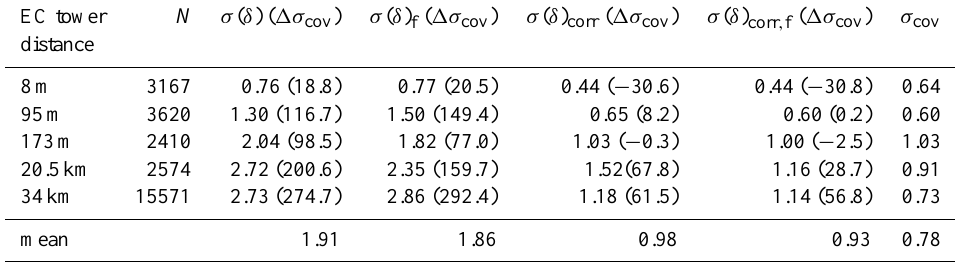
Table 2. Mean NEE uncertainty [µmolm − 2 s − 1 ] for five EC tower distances estimated with the classical two-tower approach, with and without including a weather filter ( σ(δ) , σ(δ) f ) . and with the extended two-tower approach (sfd-correction), also with and without including a weather filter ( σ(δ) corr , σ(δ) corr , f ) . The table also provides the random error σ cov [µmolm − 2 s − 1 ] estimated with the raw-data based reference method (Mauder et al.,